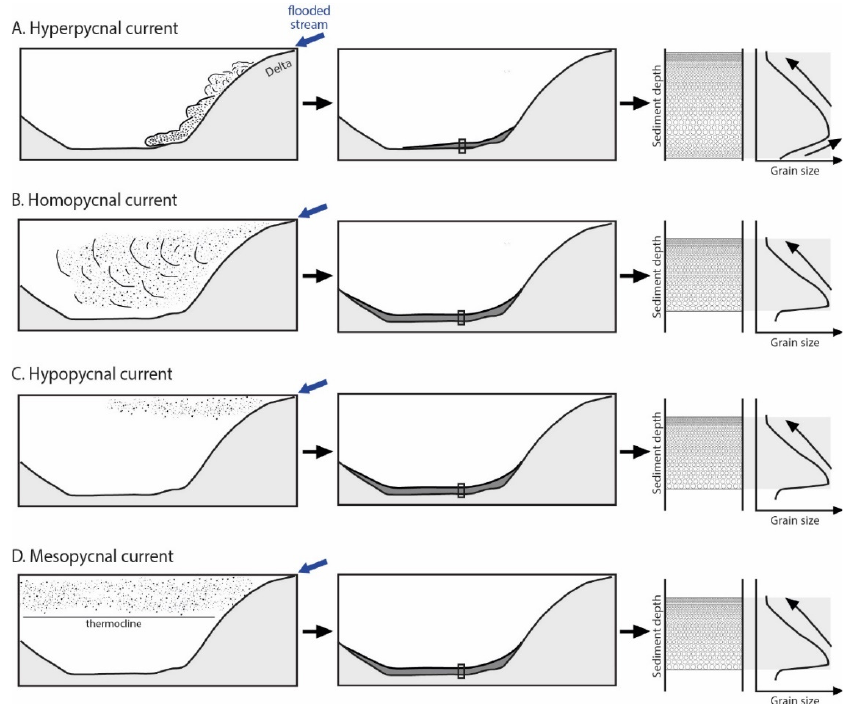
Figure 2. Illustration of the different sediment-laden currents during floods as well as the resulting deposits. The sketches on the left illustrate how the particles are spread in a lake basin according to the currents. The middle sketches highlight the different spatial extents of the flood deposits in a conceptual way. The sketches on the right show what the resulting deposits are expected to look like: ( A ) hyperpycnite and ( B – D ) graded beds. Black arrows highlight the coarsening and/or the fining-upward trends typical of these